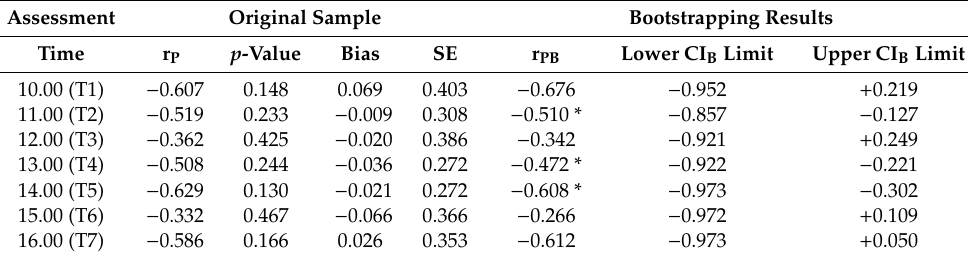
Table 2. Relationship between ethanol elimination rate and hangover severity.